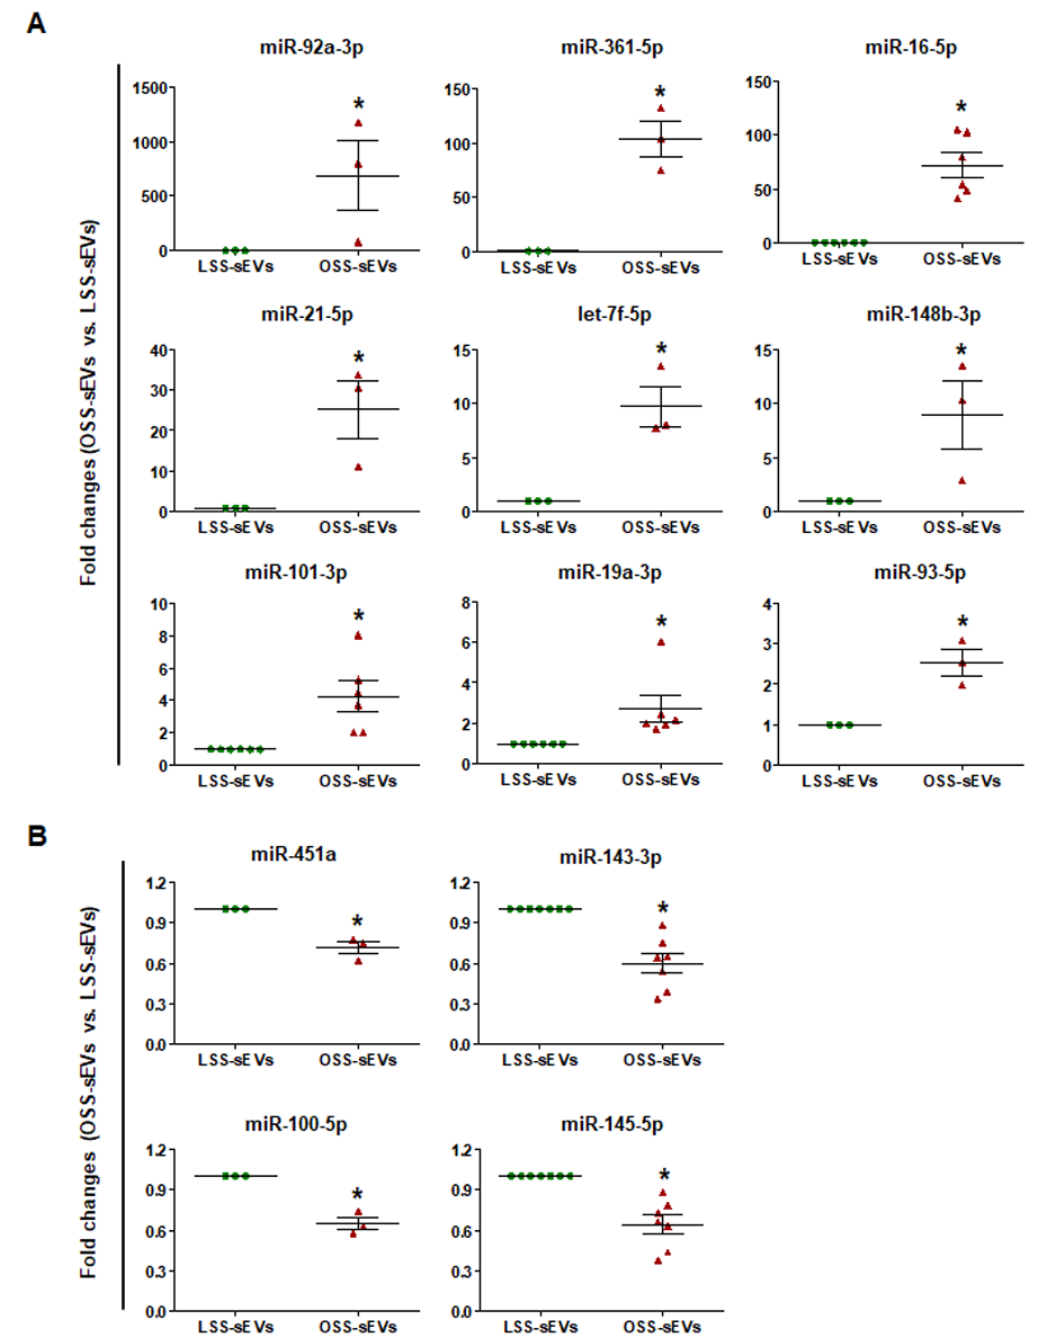
Figure A3. To assess differential expression of miRNAs in shear stress-induced EC-sEVs, total RNA was extracted from LSS- and OSS-sEVs. The 82 miRNAs from miRNA sequencing were validated by qRT-PCR. A total of 13 miRNAs were selected: 9 upregulated ( A ) and 4 downregulated ( B ) miRNAs in OSS-sEVs compared to LSS-sEVs ( n = 5; * p < 0.05 compared to LSS-sEVs). Mean ± SEM. Statistical analysis was performed using the nonparametric Mann–Whitney U test.